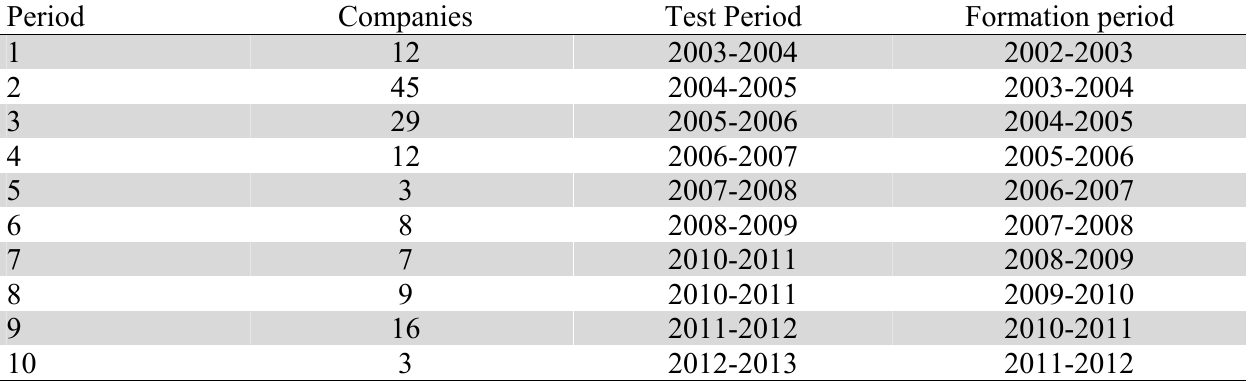
The summary of some basic